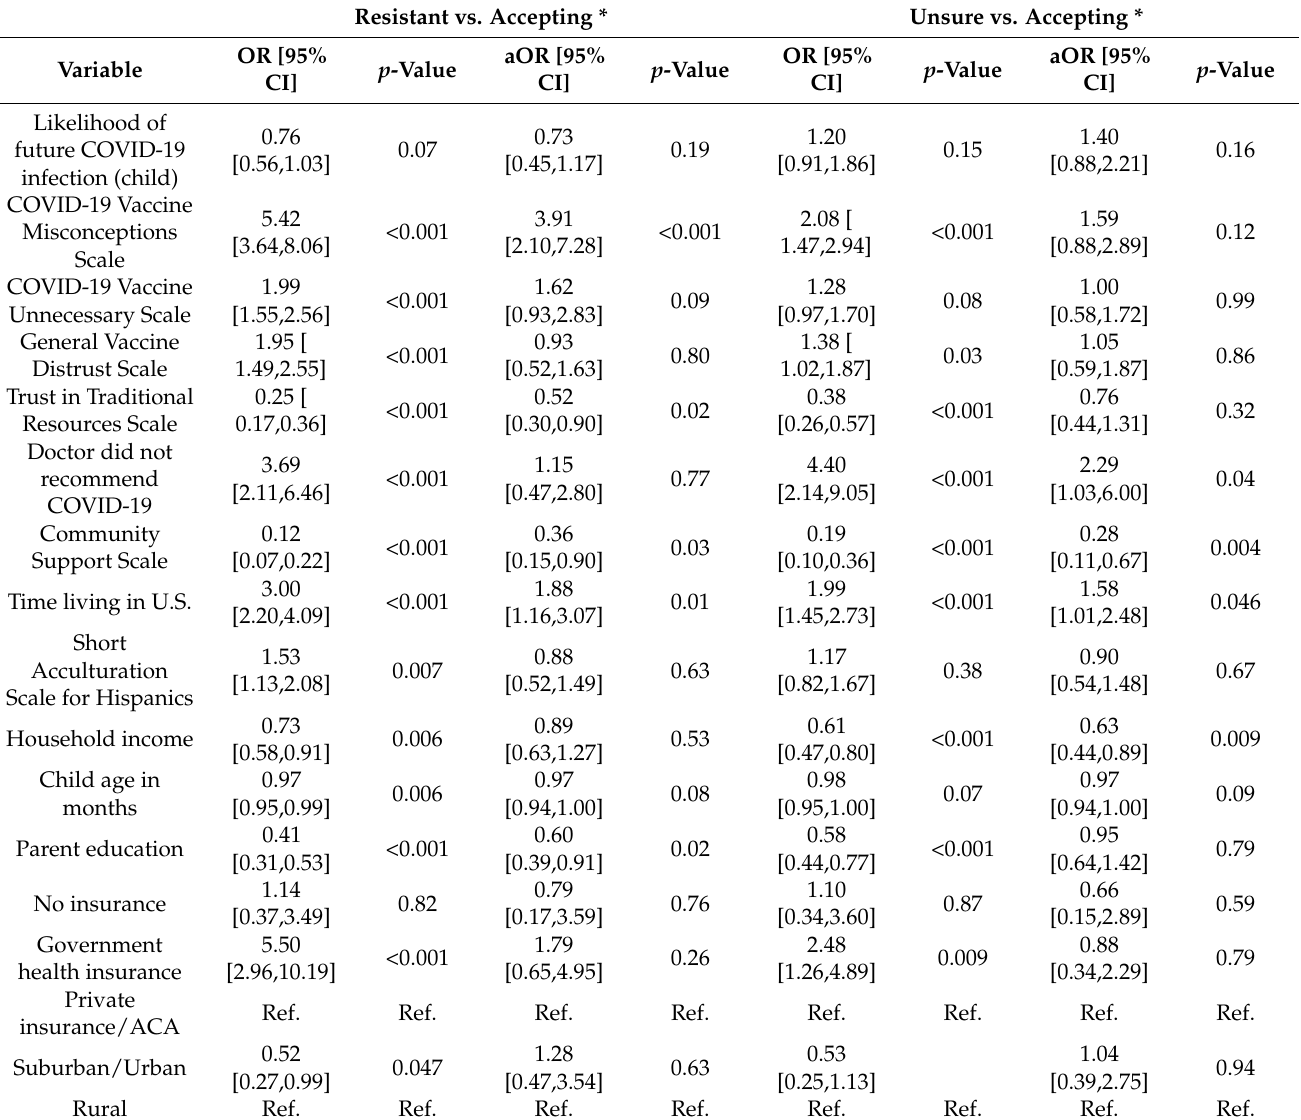
Table 4. Adjusted multinominal logistic regressions predicting COVID-19 vaccination intention for child aged 1 to 4